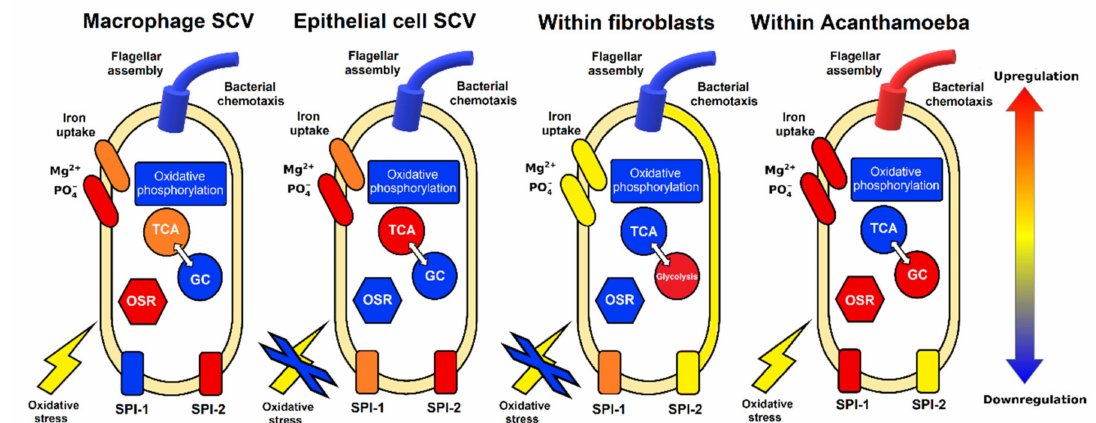
Figure 4. Response of S . Typhimurium to intracellular environment of macrophages [15,17], epithelial cells [15], fibrob- lasts [20], and A . castellanii (this study). Each symbol represents functionally related proteins. Colors reflect the expression levels of appropriate genes under each condition. Oxidative stress response, OSR; Glyoxylate cycle, GC; tricarboxylic acid cycle,